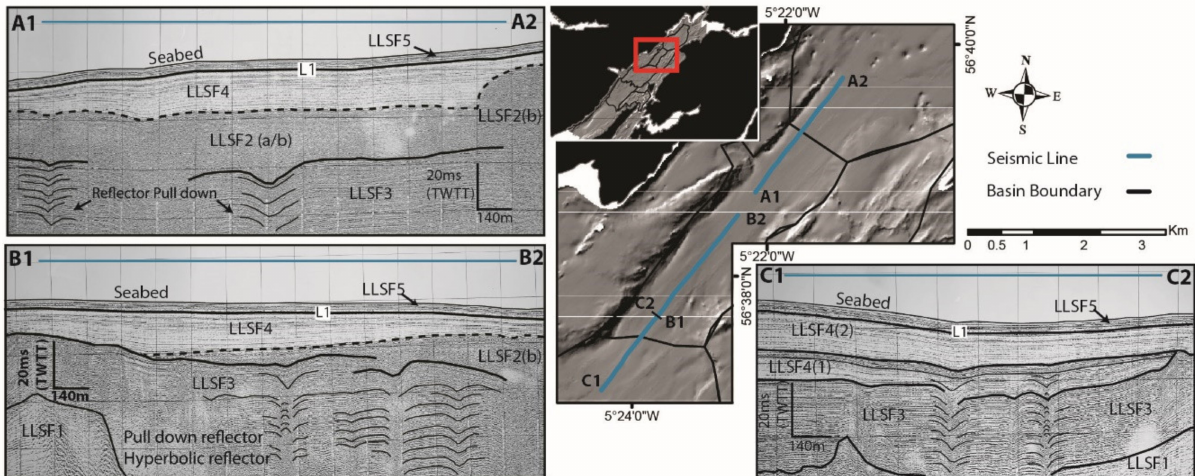
Figure 5. Analysis of selected seismic lines that contain pull-down reflectors. Map shows the position of seismic lines, basin boundaries. Labelled seismic lines sections correspond to the seismic profiles A:C. Dotted lines within seismic profiles show the position of the surface reflector for LLSF2, where LLSF2b indicates acoustic